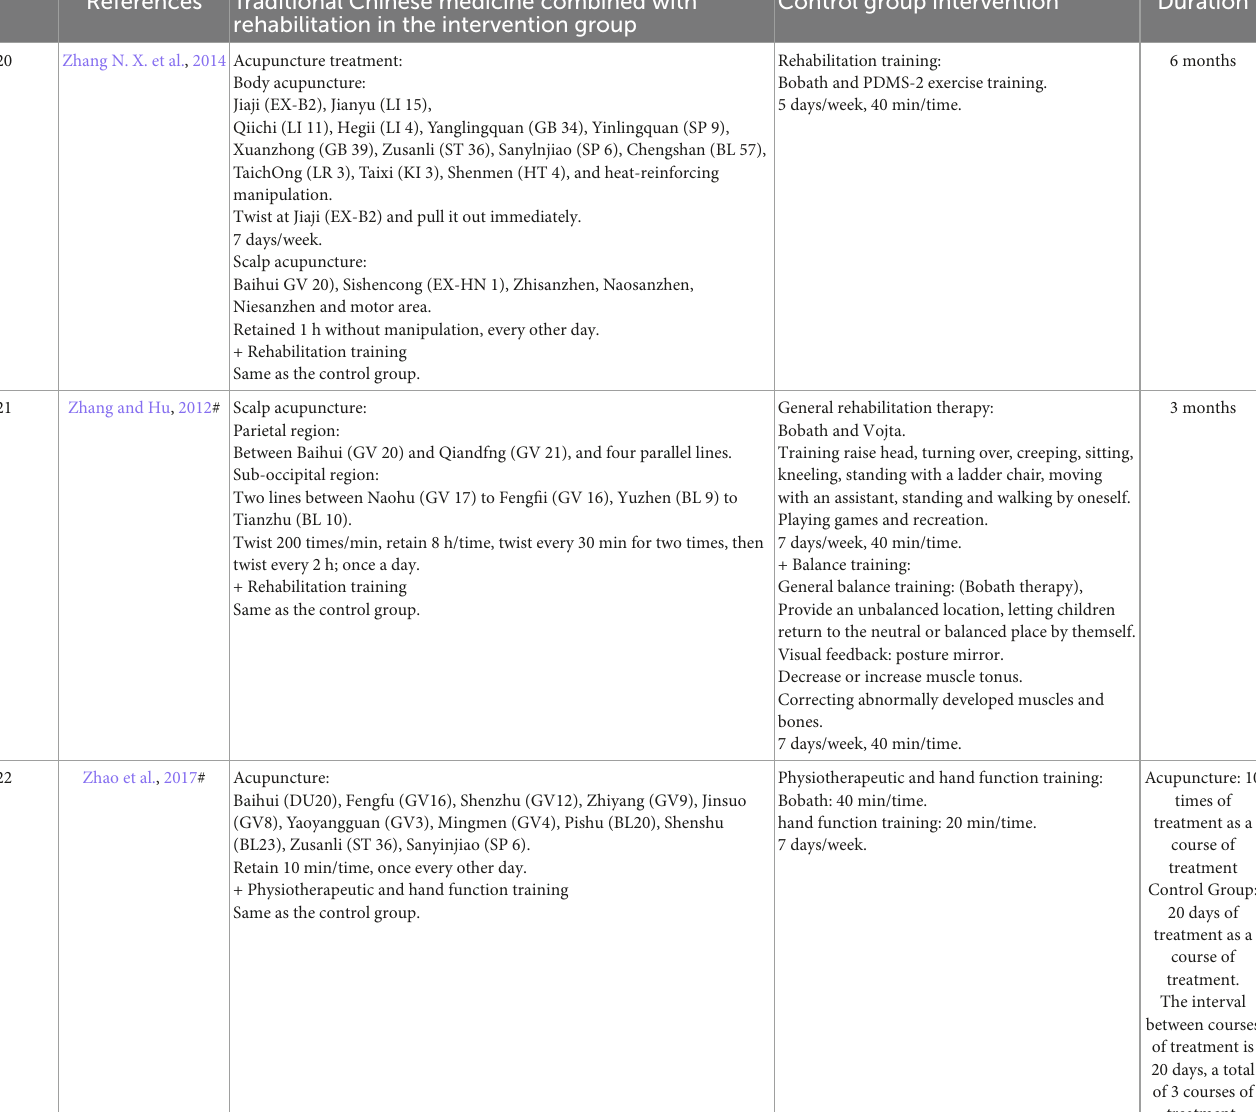
Rehabilitation training: Bobath and PDMS-2 exercise training.